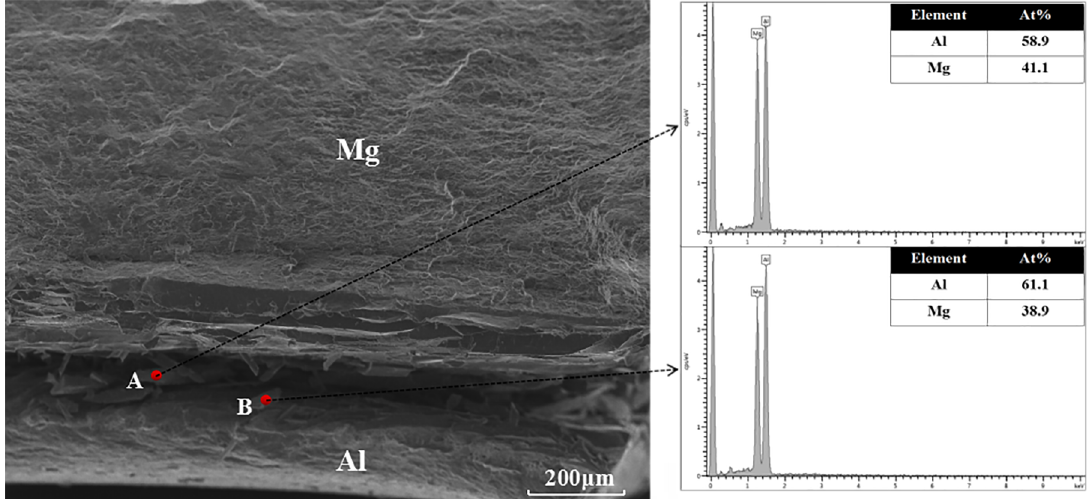
Figure 12. Interface fractograph obtained from the specimen annealed at 400°C for 2 h and EDS spectra from layers marked by letters A and